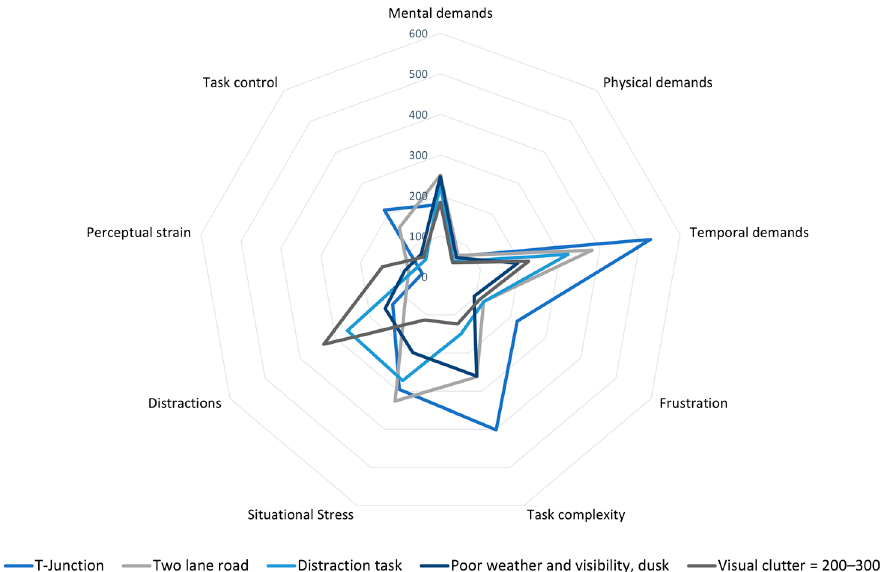
Figure 8. Raw scores for scenarios with significantly higher workload. The raw scores are broken down into the different workload components measured with the SIM-TLX, i.e., mental demands, physical demands, temporal demands, frustration, task complexity, situational stress, distractions, perceptual strain and task control.